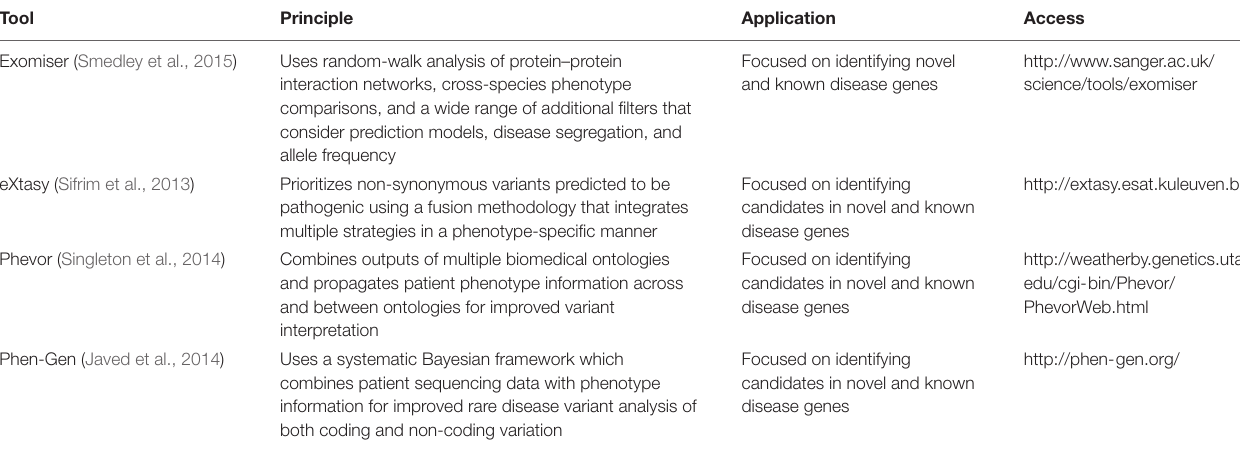
TABLE 1 | Four phenotype-driven tools for prioritization of known and novel disease genes.